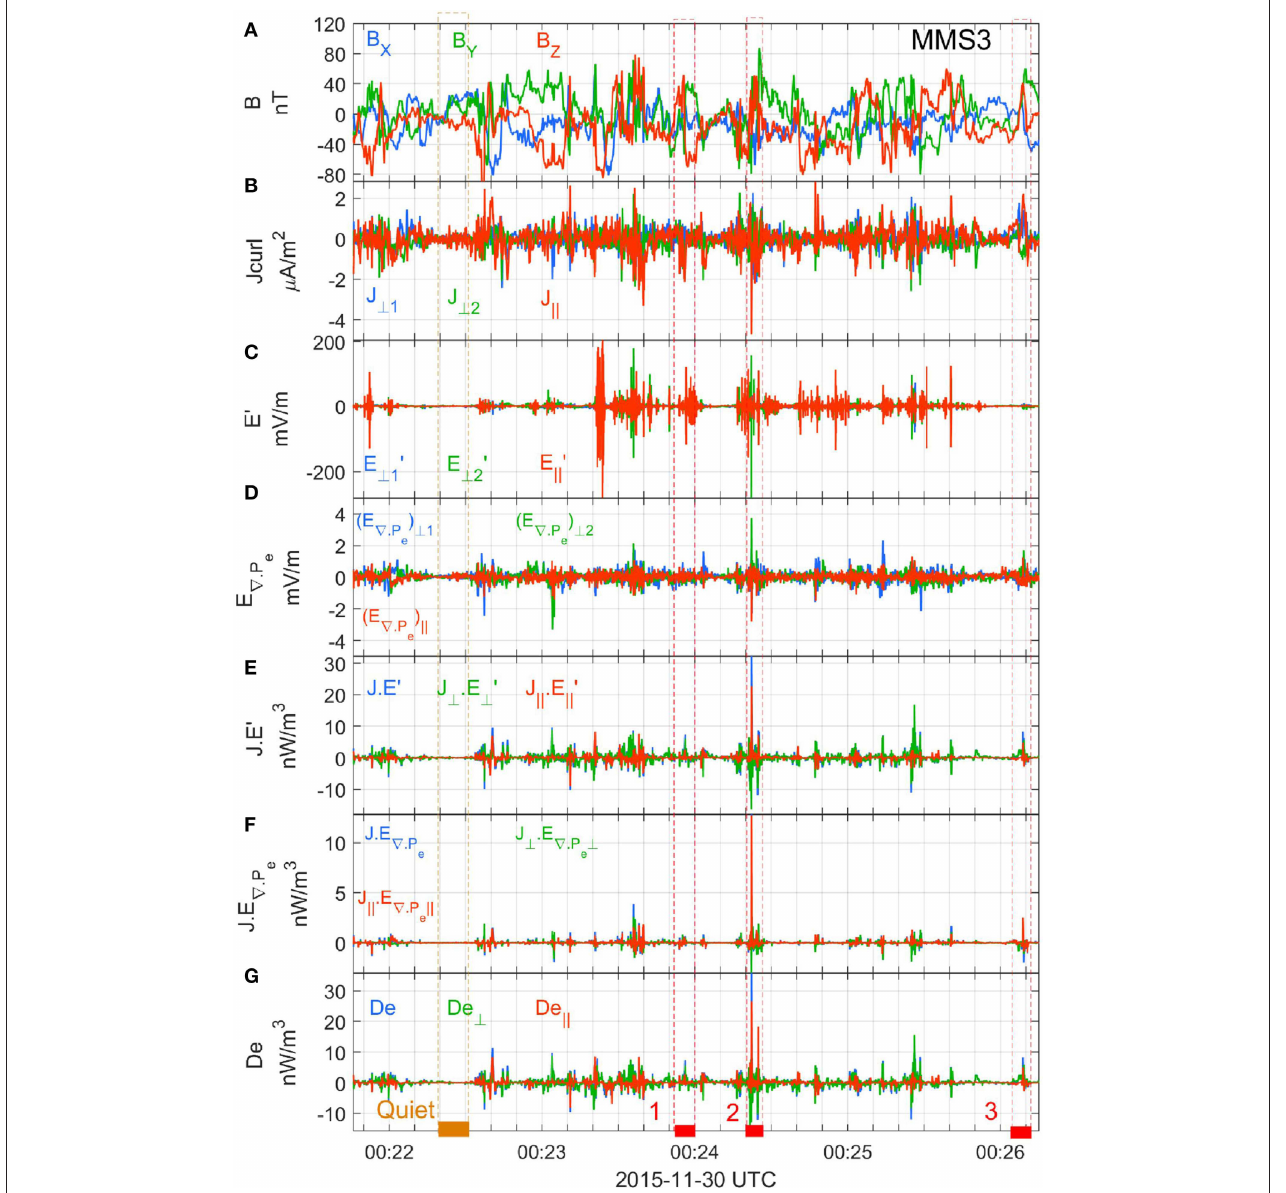
FIGURE 2 | (A) magnetic field components in GSE ( B X , B Y , B Z ); (B) curlometer current density components in field-aligned (FAC) coordinates ( J ⊥ 1 , J ⊥ 2 , J || ); (C) electric field in the moving electron frame E ′ = E + V e × B in FAC coordinates; (D) electric field calculated from the divergence of electron pressure tensor ( E ∇ . P